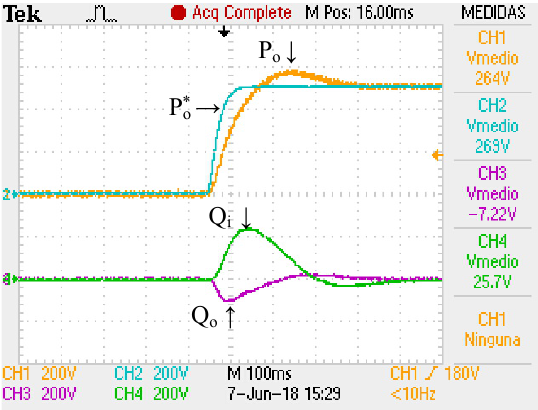
Figure 9. Total active and reactive power.